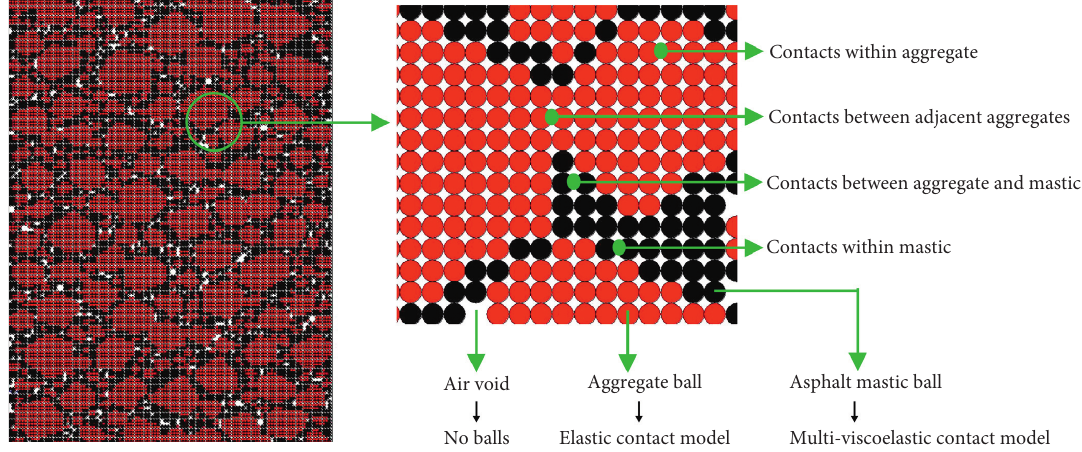
Figure 1: Numerical sample of asphalt concrete.